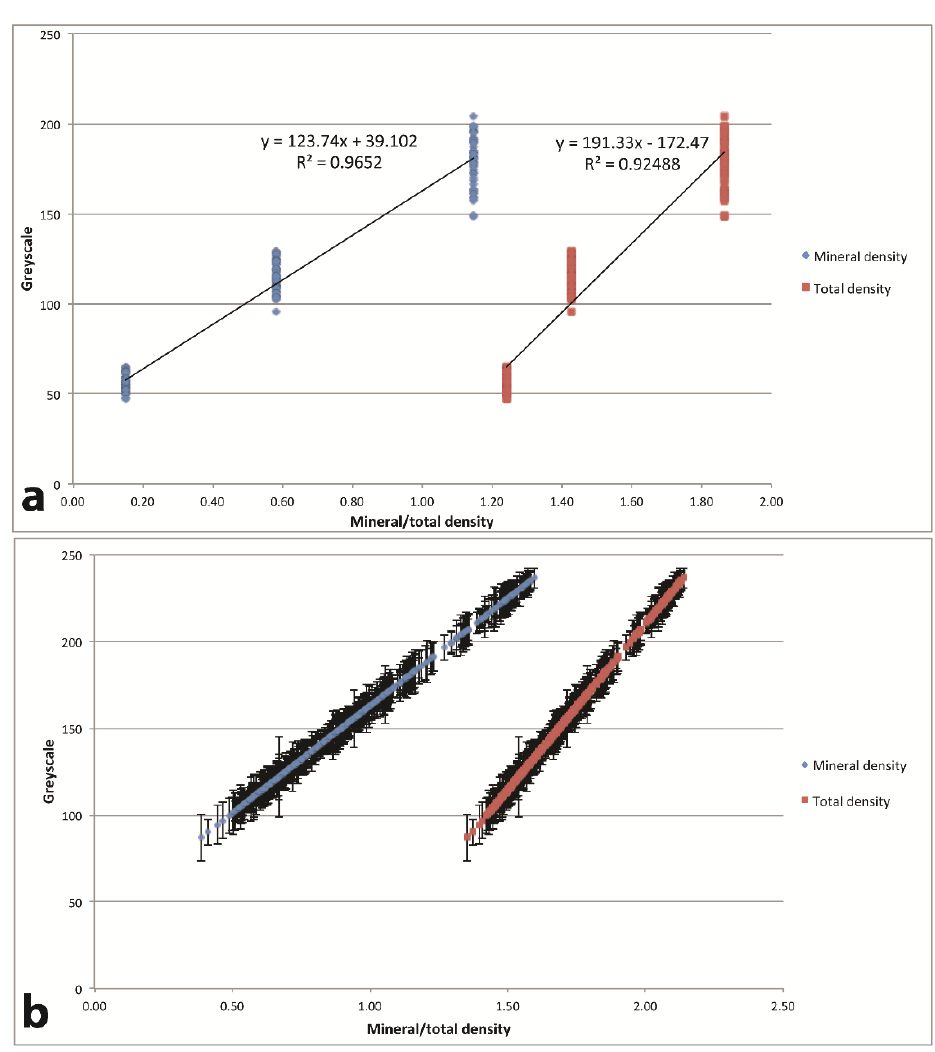
Fig. 8. a) Scatter plot and linear regression of greyscale values versus mineral concentration and total density for hydroxyapatite calibration standards. b) Scatter plot of greyscale values versus mineral concentration and total density for the franciscana Pontoporia blainvillei (UFSC